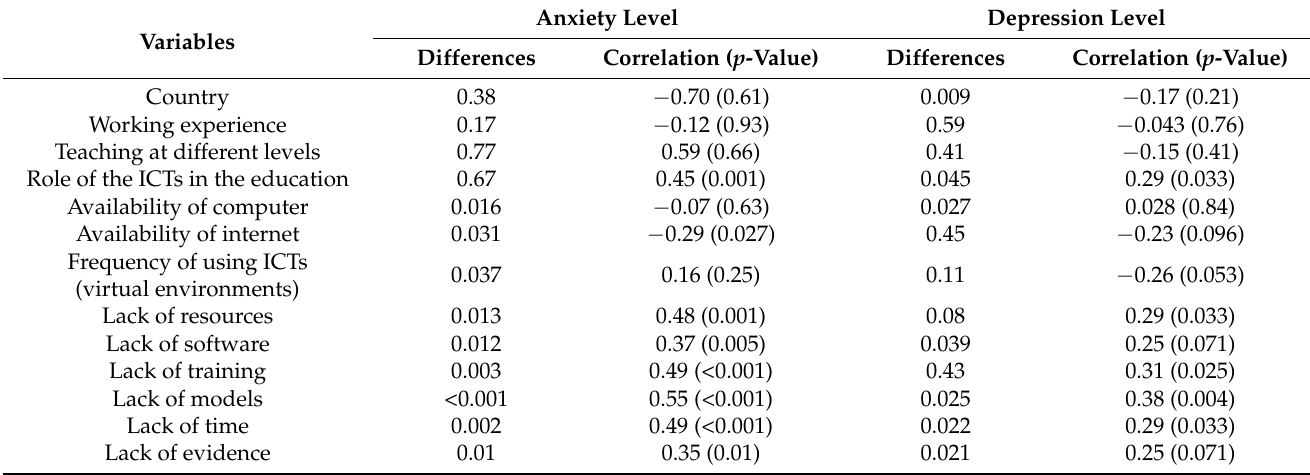
Table 3. Differences and correlations of the variables and the anxiety and depression levels.